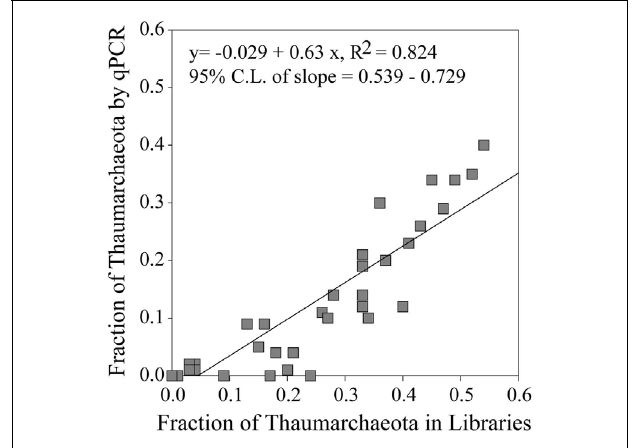
FIGURE 4 | Fraction ofThaumarchaeota rrs found in 454 pyrosequencing libraries versus the fraction ofThaumarchaeota rrs determined from qPCR data. Line represents a model II pairwise regression.